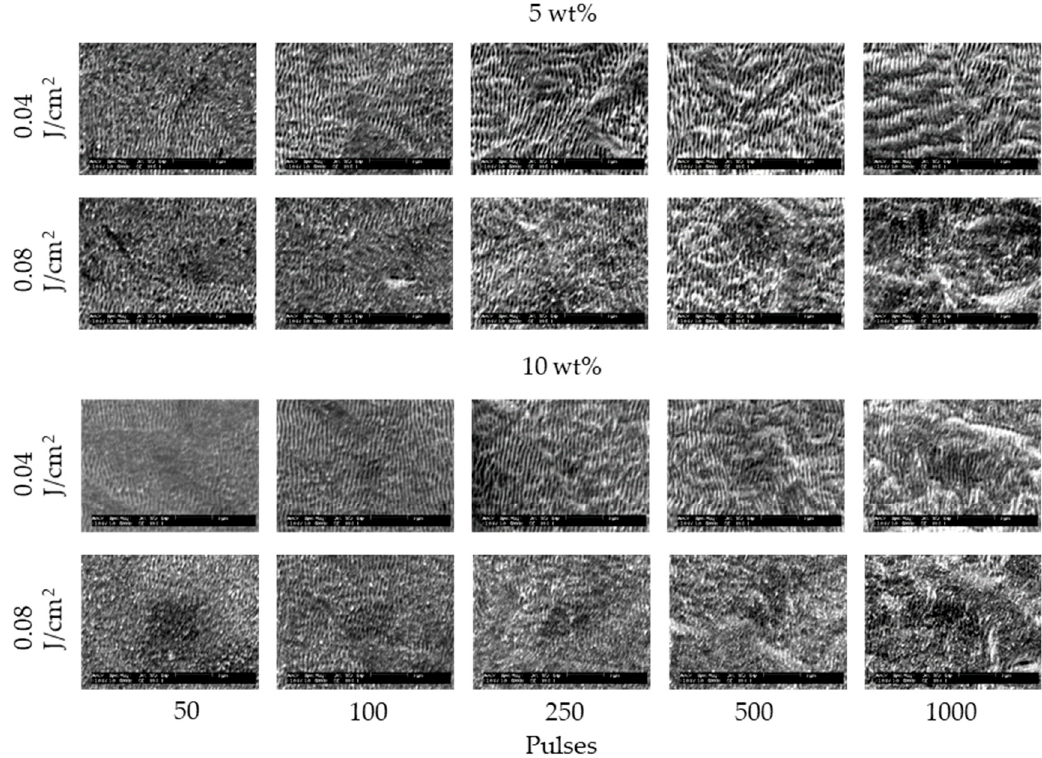
Figure 5. SEM images of 304 stainless steel irradiated with N = 50–1000 pulses at F = 0.04–0.08 J/cm 2 in 5 and 10 wt% NaNO 3 solutions. The laser beam has the polarization in a lateral direction.